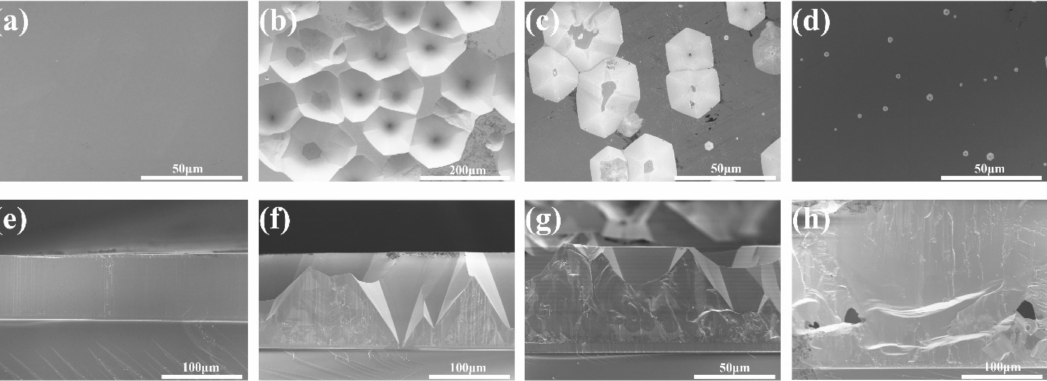
Figure 1. Surface SEM images of gallium nitride (GaN) crystals grown with a di ff erent process: S1 ( a ),